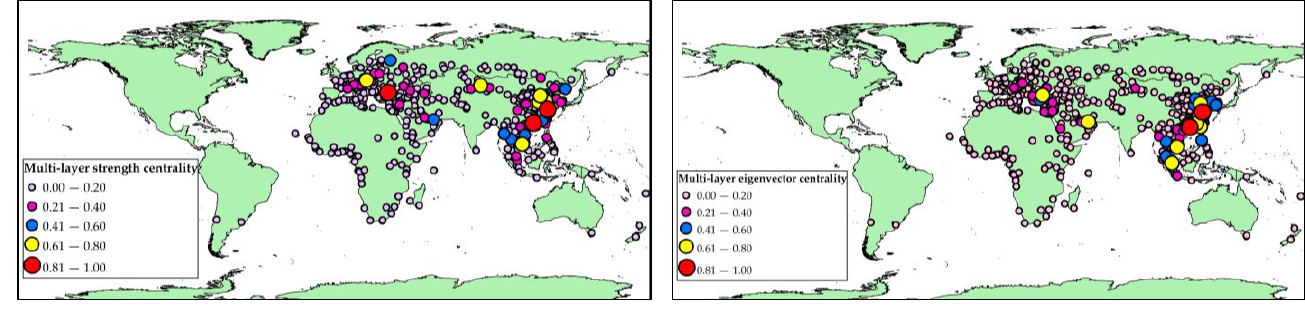
Figure 4. Rank of different multi-layer centrality of node cities.